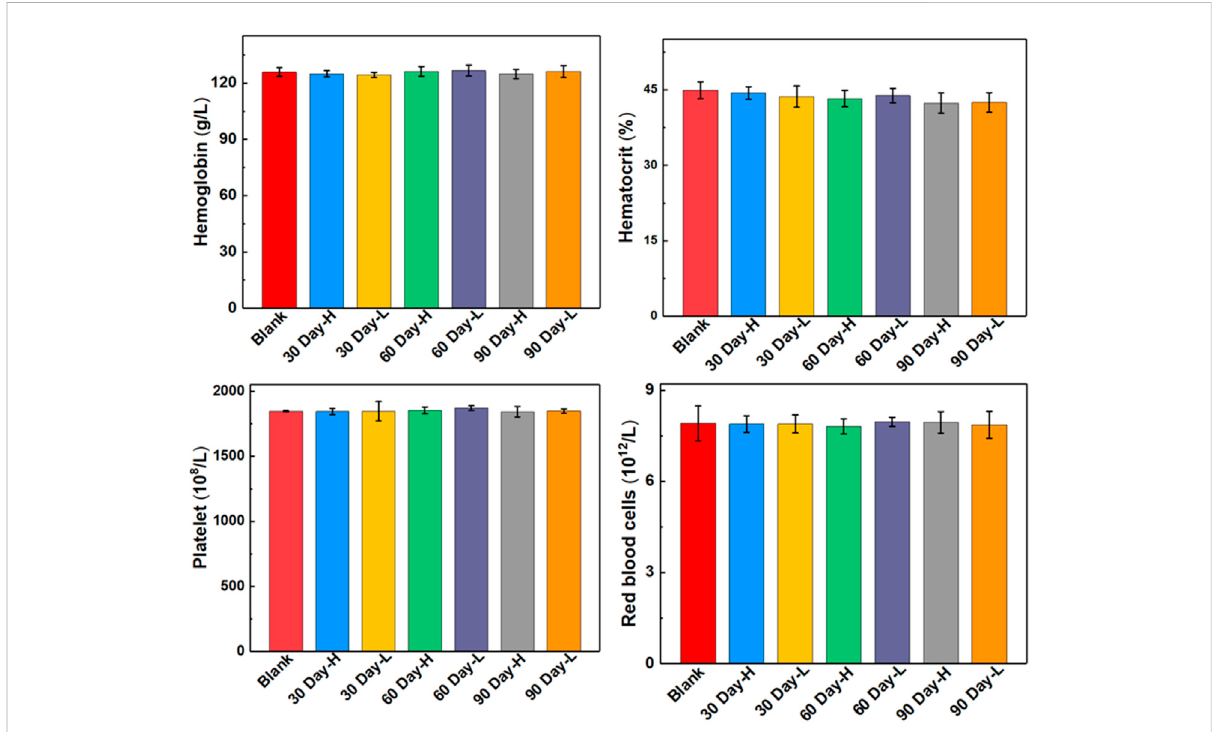
FIGURE 5 Blood routine indexes at different time points after ULU nanoliposome (20 mg/kg, n = 3) were injected into the tail vein of healthy